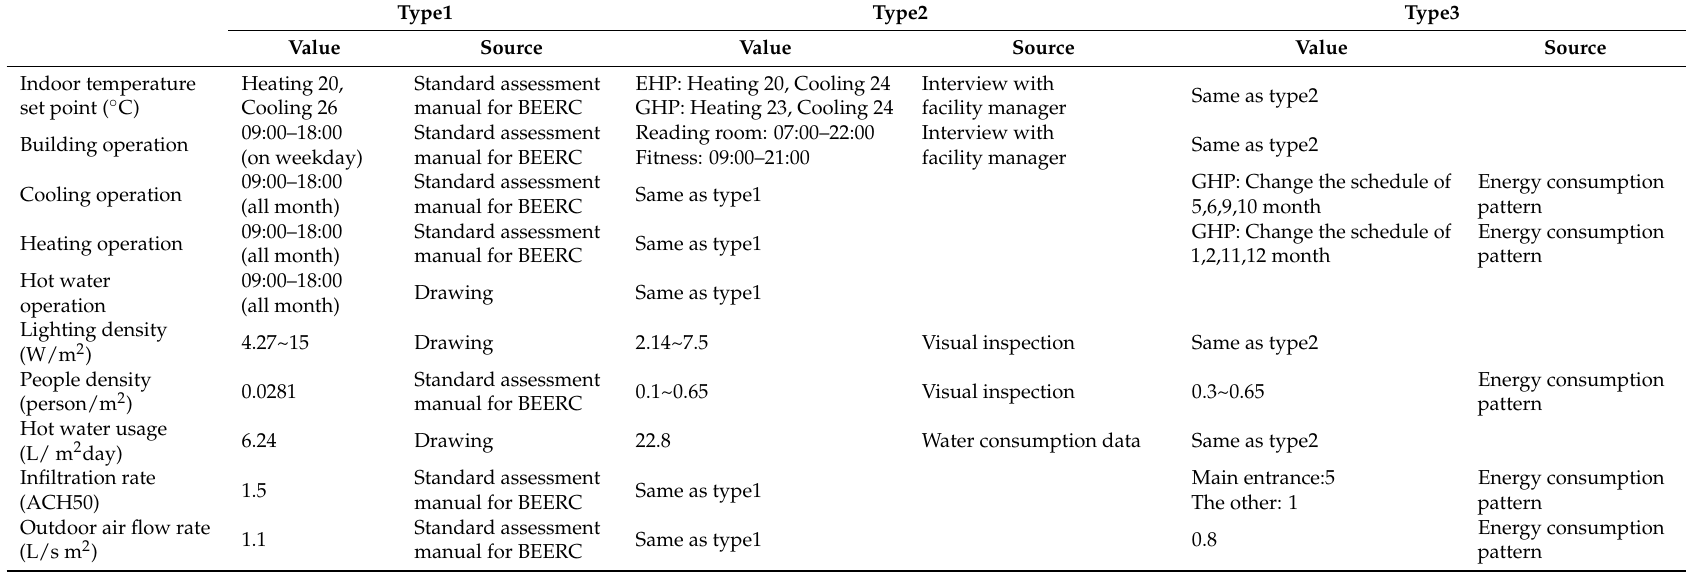
Table 7. Investigated and estimated parameters of OB1 according to the assessment type.